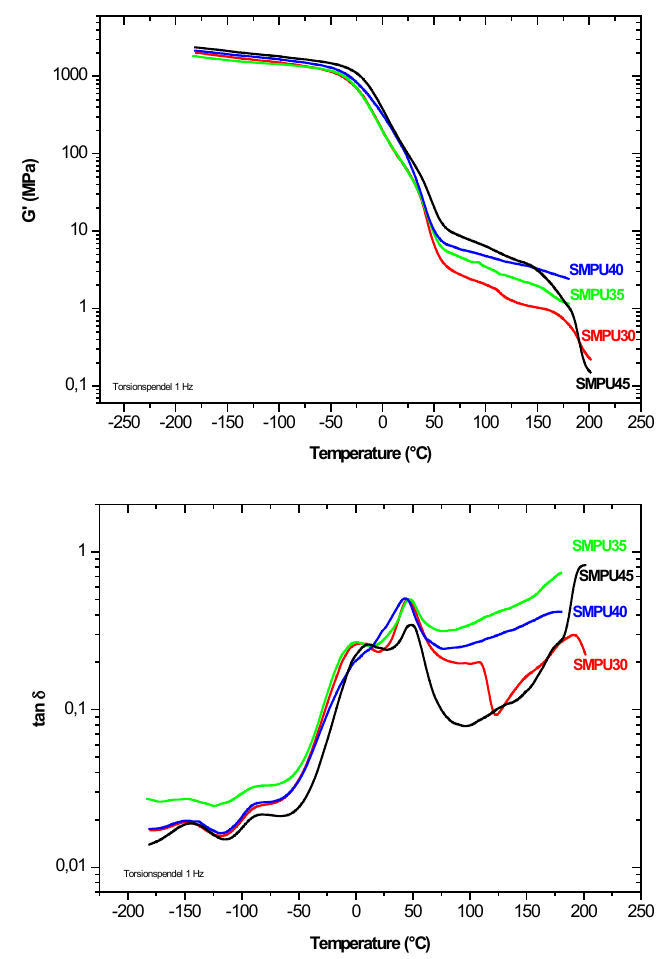
Figure 4. DMA scans of SMPUs with varying hard segment